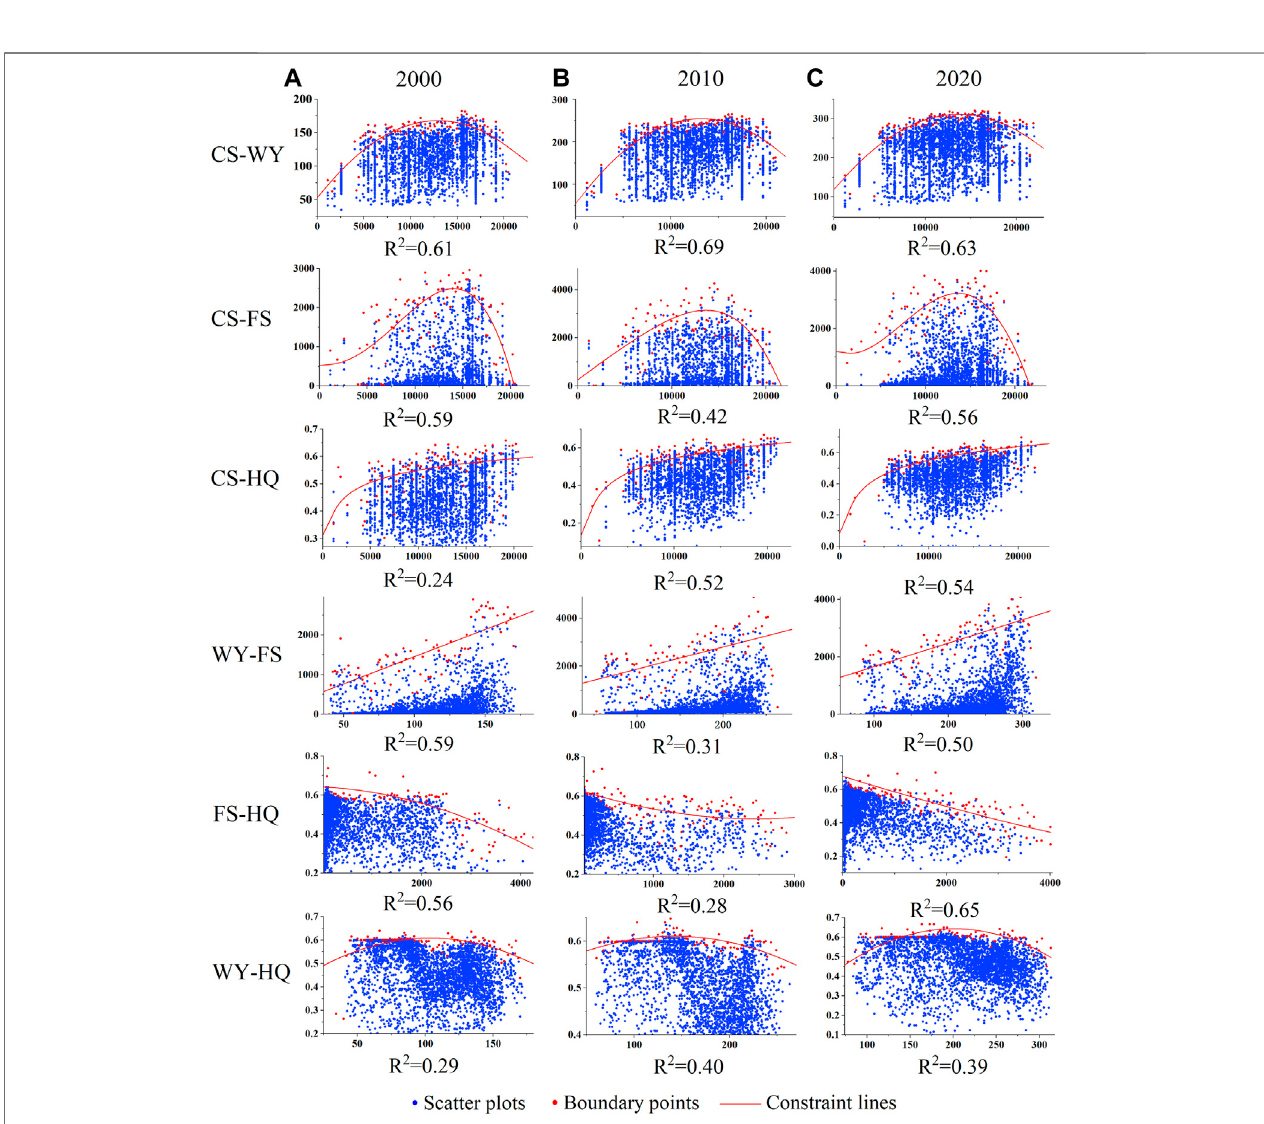
FIGURE 6 | Constraint effects between paired ESs in Ordos (A) 2000 (B) 2010 (C) 2020.